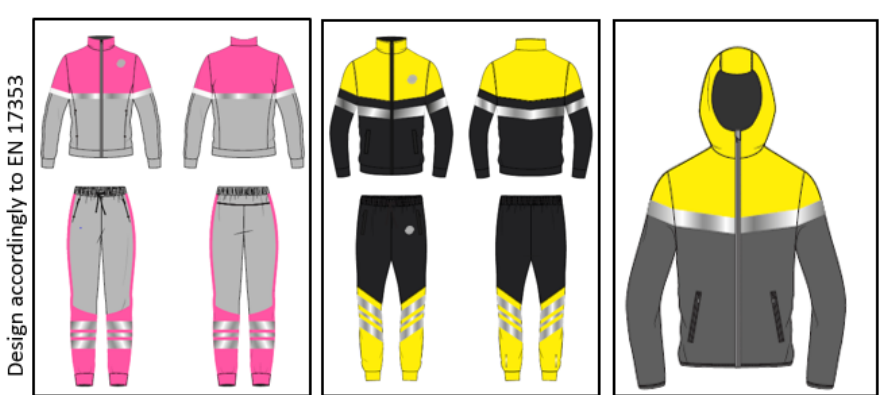
Figure 7. Design of the sportswear collection developed accordingly to EN17535.